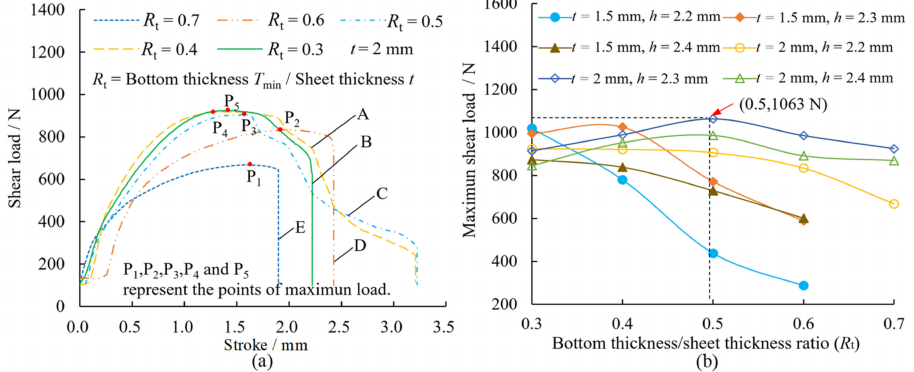
Figure 8. Variation of the shear loads on joints with ( a ) die depth h = 2.2 mm and ( b ) the bottom thickness/sheet thickness ratio ( R t ).